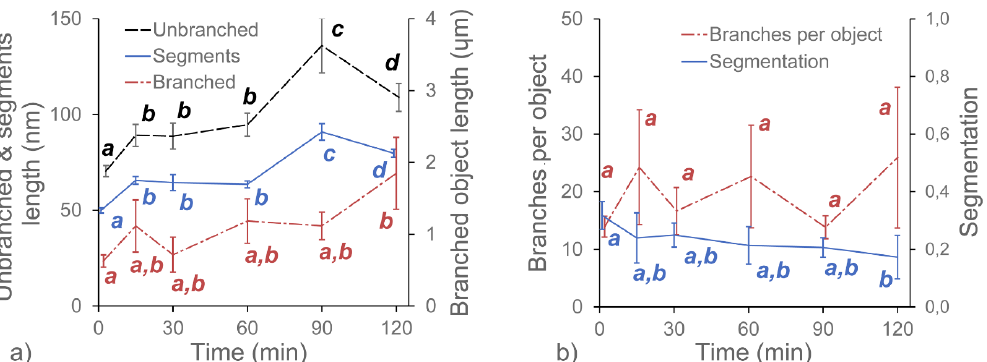
Figure 4. Changes in the average values of the structural parameters of DASP treated with RHA with respect to the duration of enzyme treatment. Different letters indicate significant differences (according to ANOVA with p = 0.05). Bars indicate 95% confidence intervals for mean values.